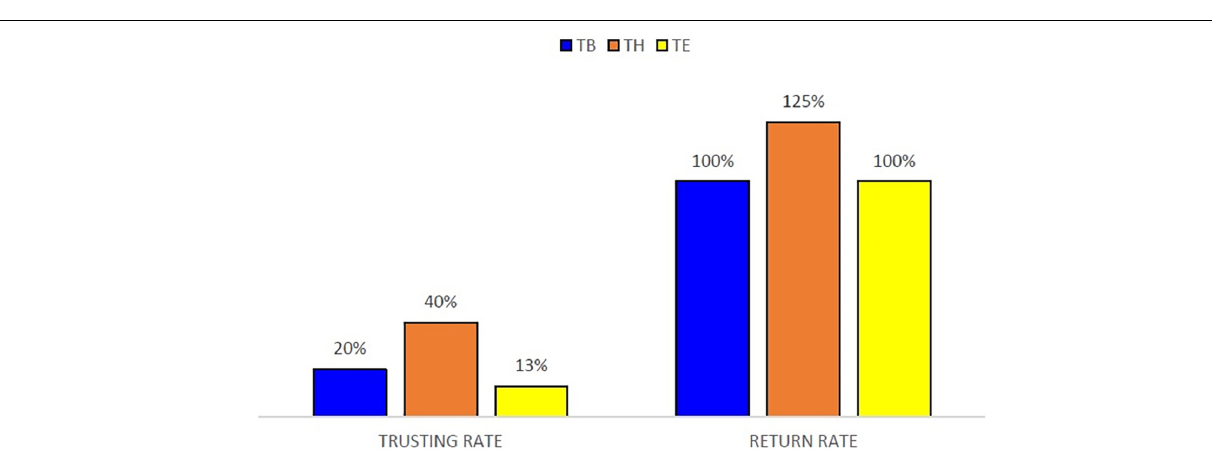
FIGURE 4 | Median decisions in the TG, per